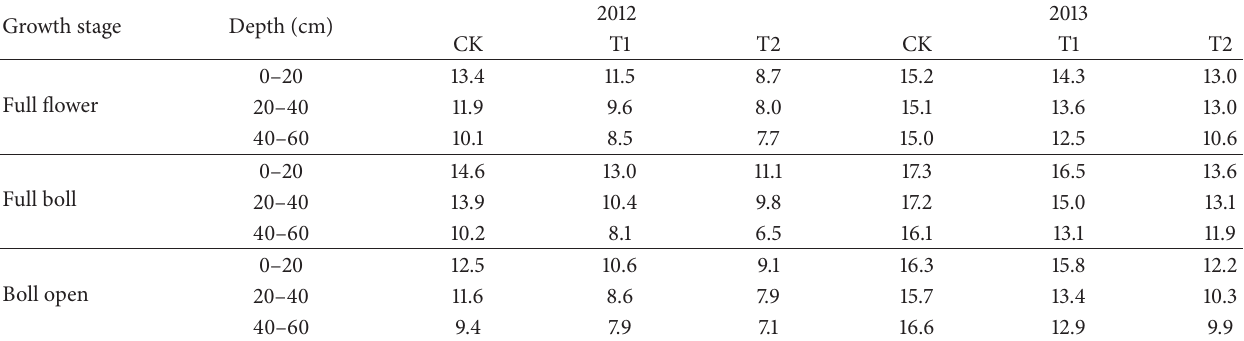
Table 1: Volumetric soil water content (%) at three depths and at three times during the 2012 and 2013 growing seasons. Growth stage Depth (cm)